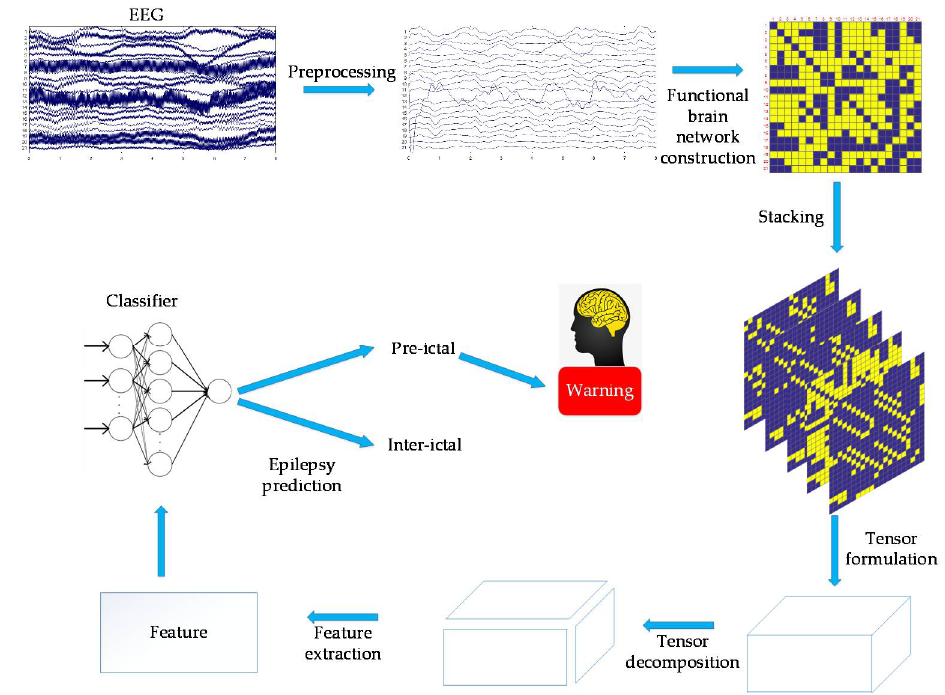
Figure 1. This figure shows the main flow chart.